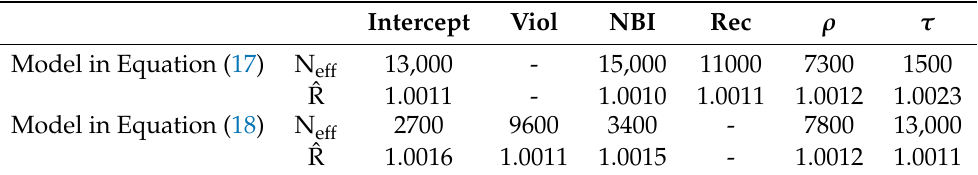
Table 5. Convergence diagnostics for the spatial conditional normal Poisson models in Equations (17) and (18) fitted to the Colombian infant mortality rates data